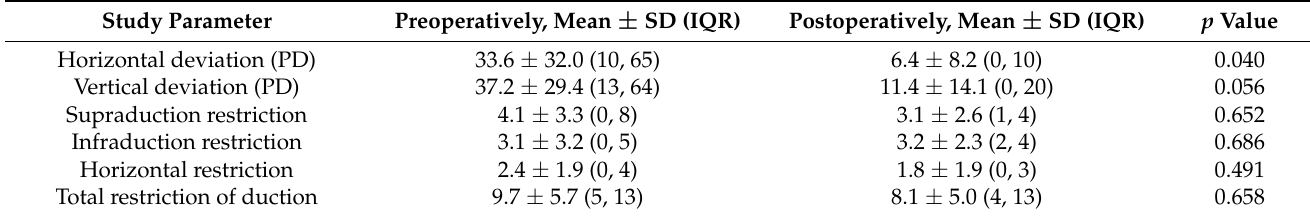
Table 3. Pre- and postoperative outcomes of patients who underwent surgery (n =